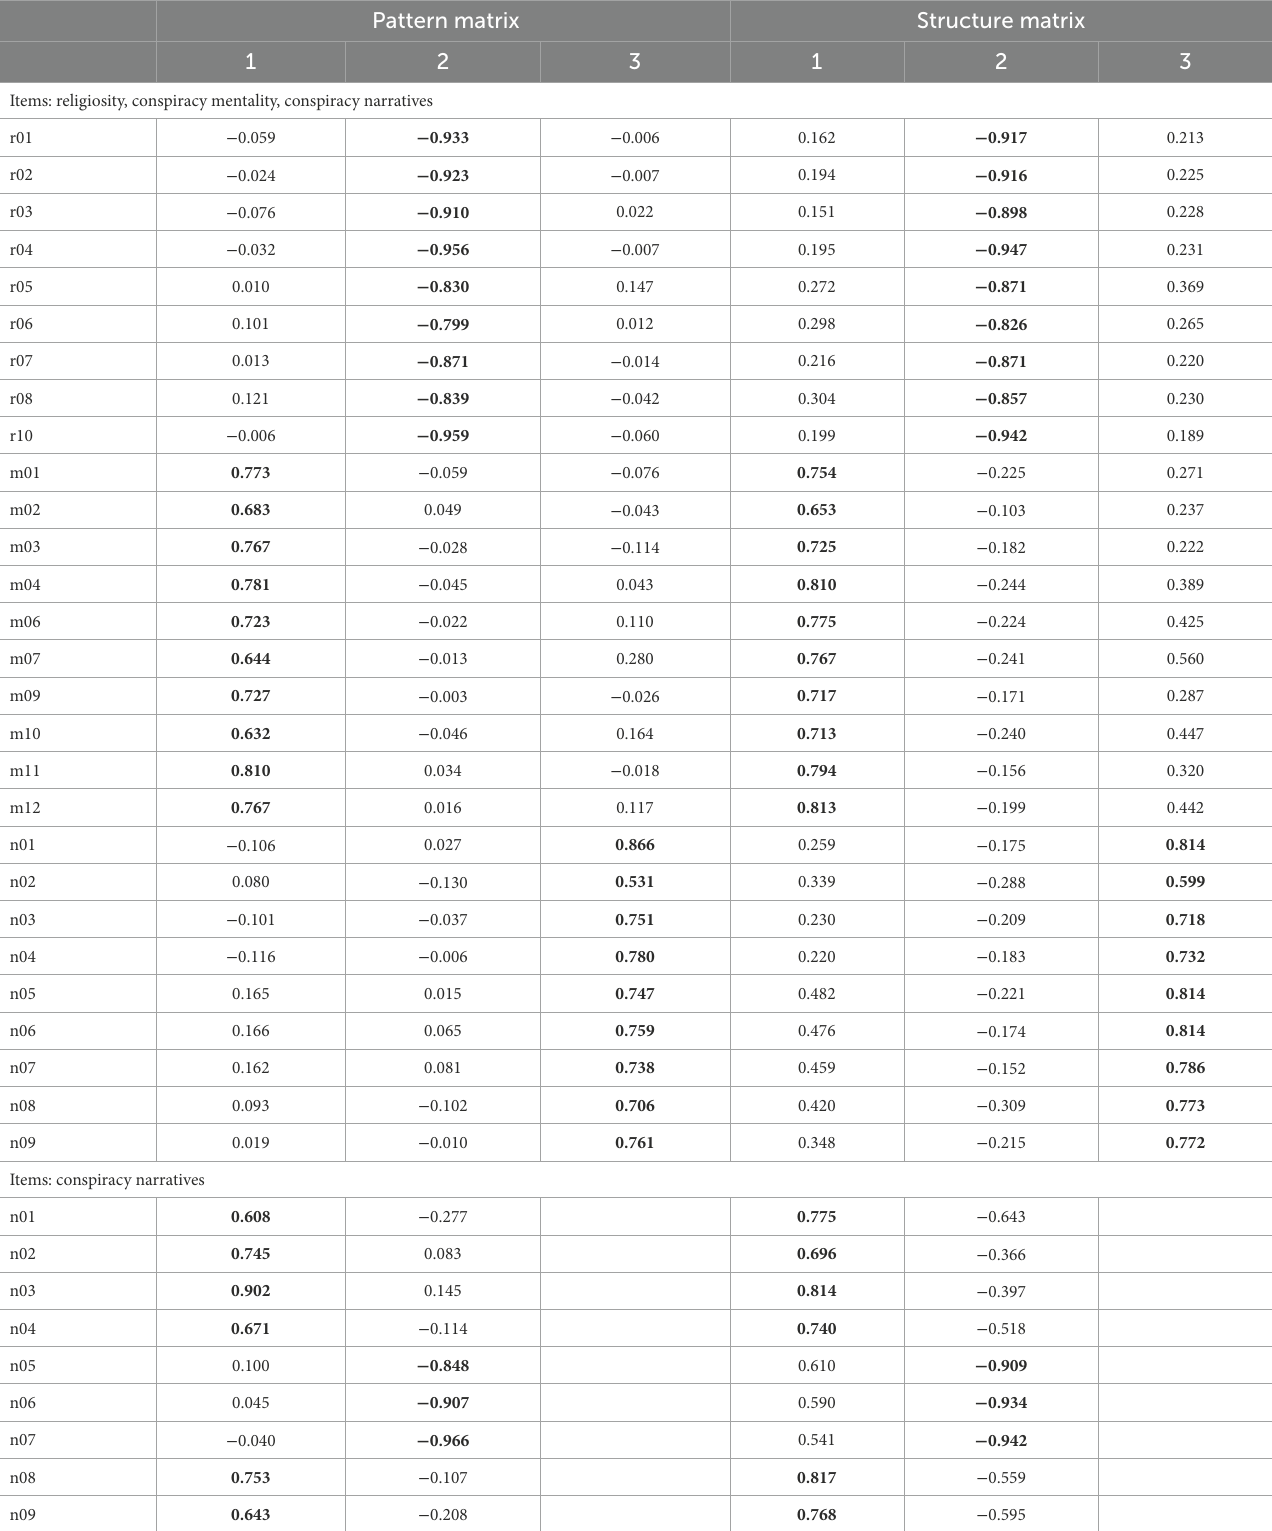
TABLE 2 Principal component analyses: factor loadings. Pattern matrix Structure